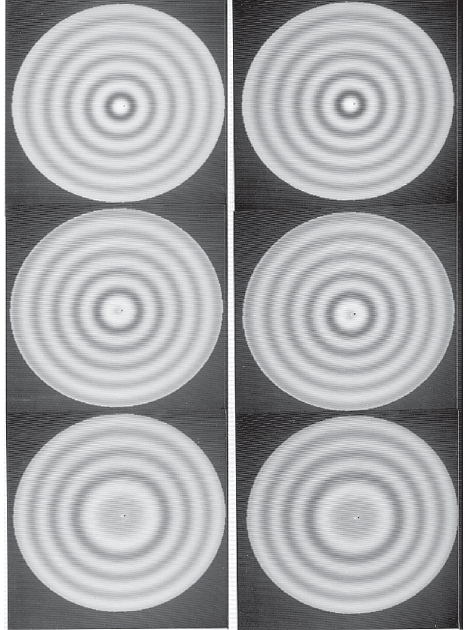
Figure 2. Photographs of spheri- cal Bessel functions, j n (left), and cylindrical Bessel functions, J n (right), for n = 0 (top), n = 2 (cen- ter) and n = 8 (bottom).